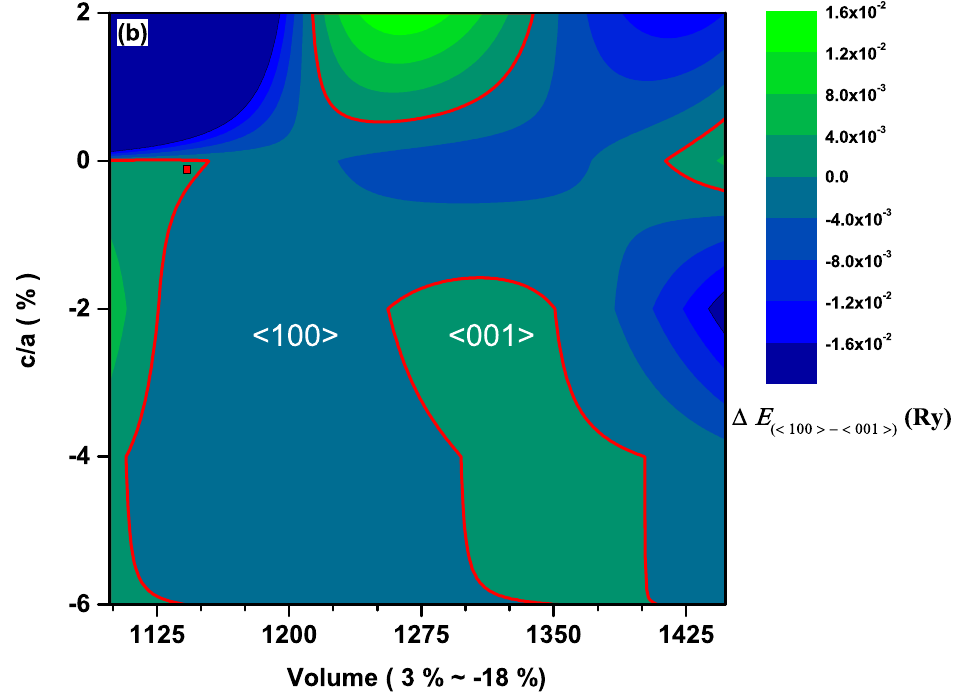
Figure 3. The same as Figure 2 except for the CeAgSb 2 compound. The red square symbol corresponds to the E SOC calculated above P c